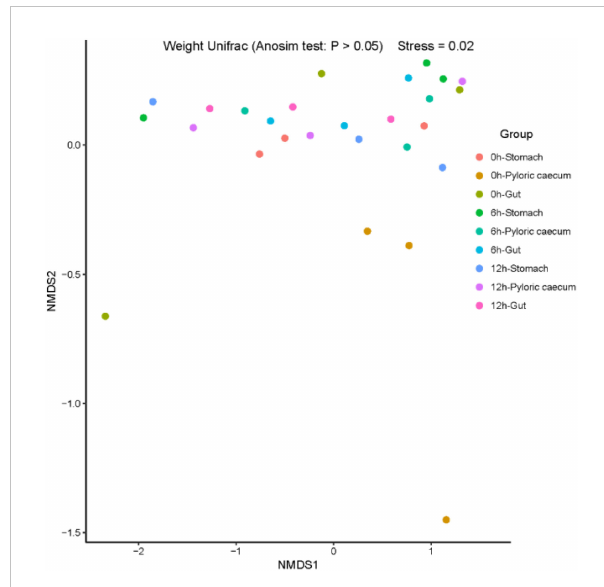
FIGURE 5 The nonmetric multidimensional scaling (NMDS) analysis.